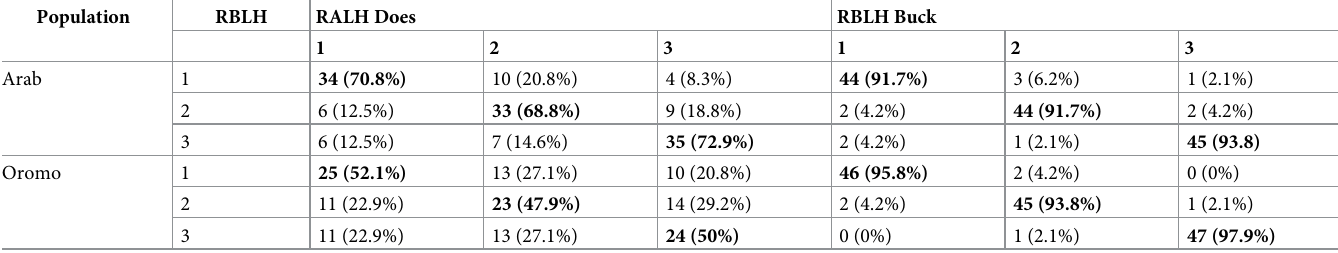
Table 5. Rank proportions before and after provision of information in